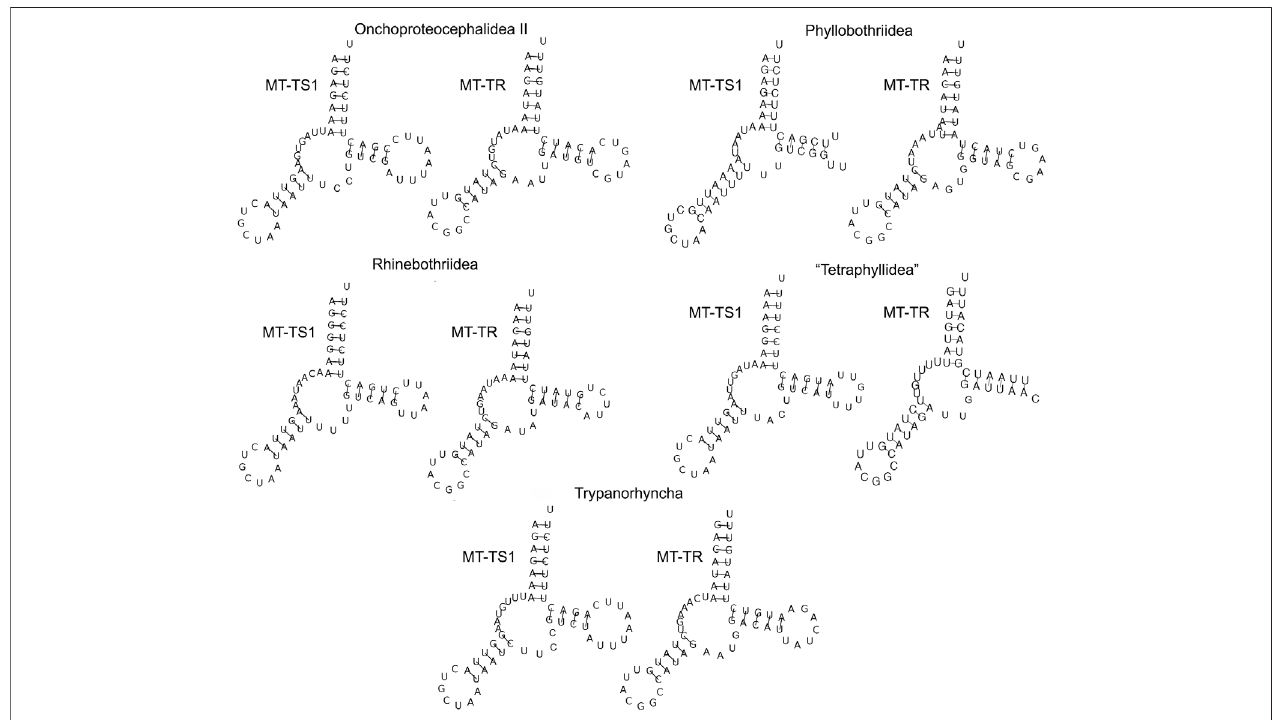
FIGURE 4 | The secondary structure of MT-TS1 and MT-TR from fi ve orders of cestodes (one specimen representing each order) illustrates the lack of DHU-arms found for these tRNAs.